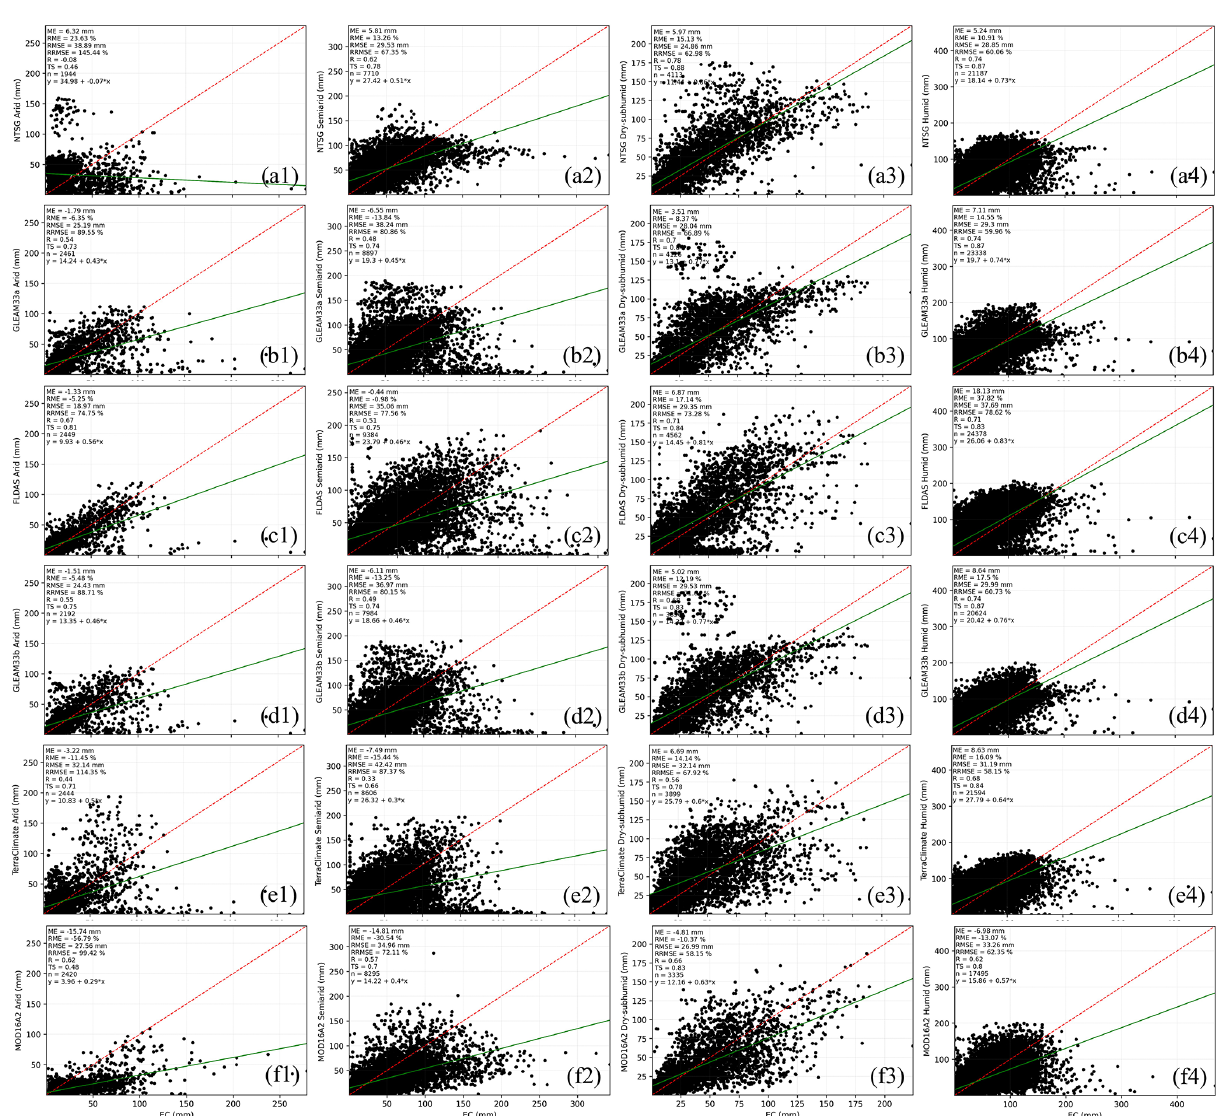
Figure 10. Monthly ET products (NTSG: a ; GLEAM33a: b ; FLDAS: c ; GLEAM33b: d ; TerraClimate: e ; MOD16A2: f ) against flux EC ET aggregated for all sites for each climate class (arid: 1; semiarid: 2; dry subhumid: 3; humid: